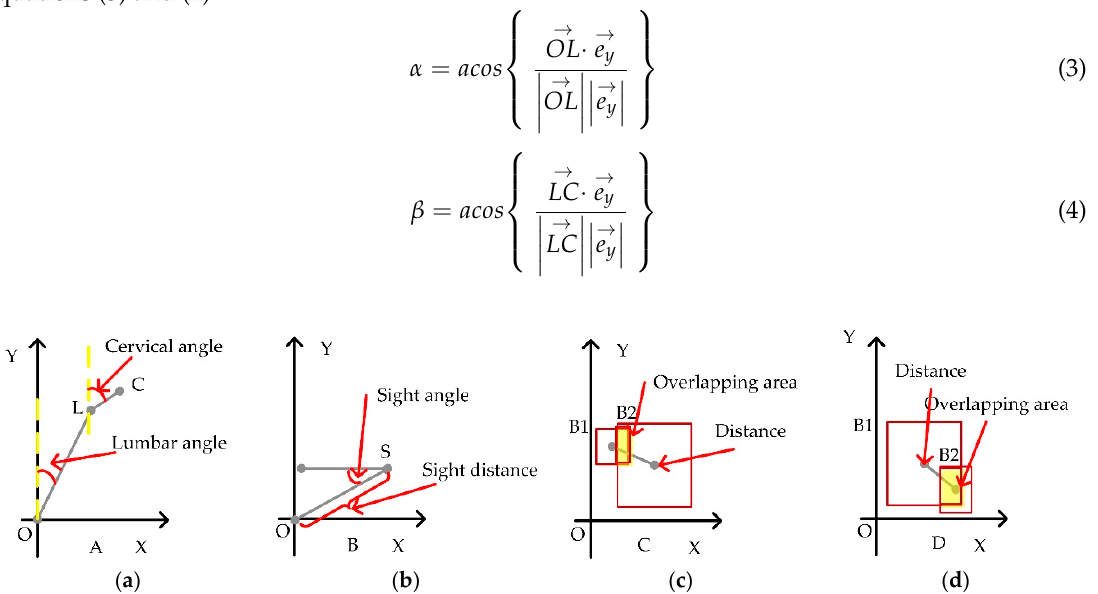
Figure 7. The calculation of semantic features. ( a – d ) correspond to the calculation of semantic features A, B, C and D.